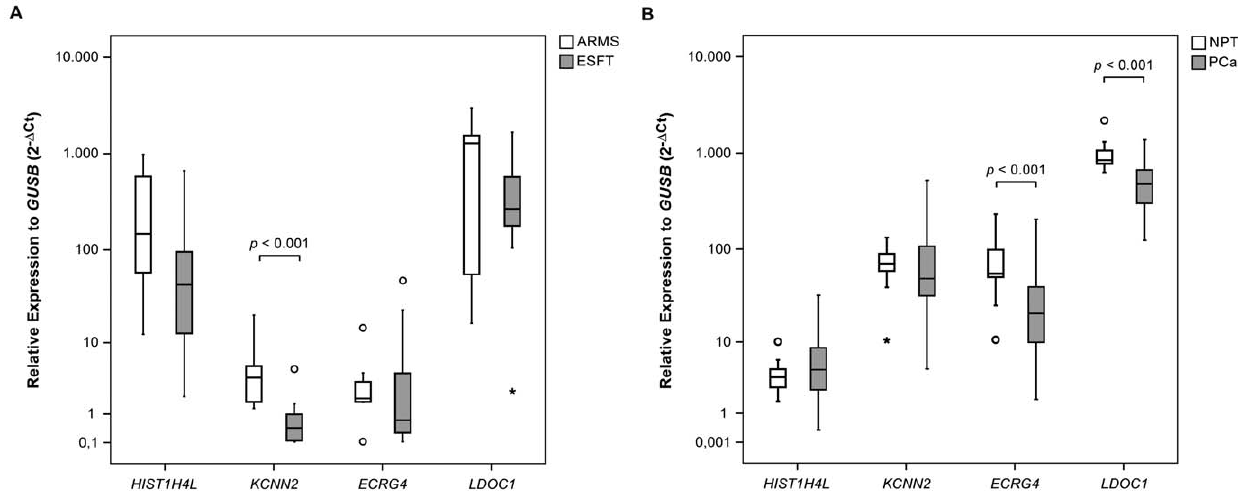
Figure 3. Box-plot representation of the qRT-PCR data for the four genes described as EWSR1-FLI1 targets and associated with PCa samples harboring ERG rearrangements ( HIST1H4L , KCNN2 , ECRG4 and LDOC1 ). A) ESFT versus ARMS samples; B) PCa samples versus NPT samples. A p value is shown whenever the differences in each two group comparison reach significance ( p , 0.05).